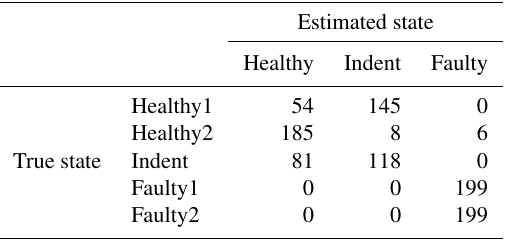
Table 15. Accuracy values for using the 3000rpm feature set for the 1500rpm